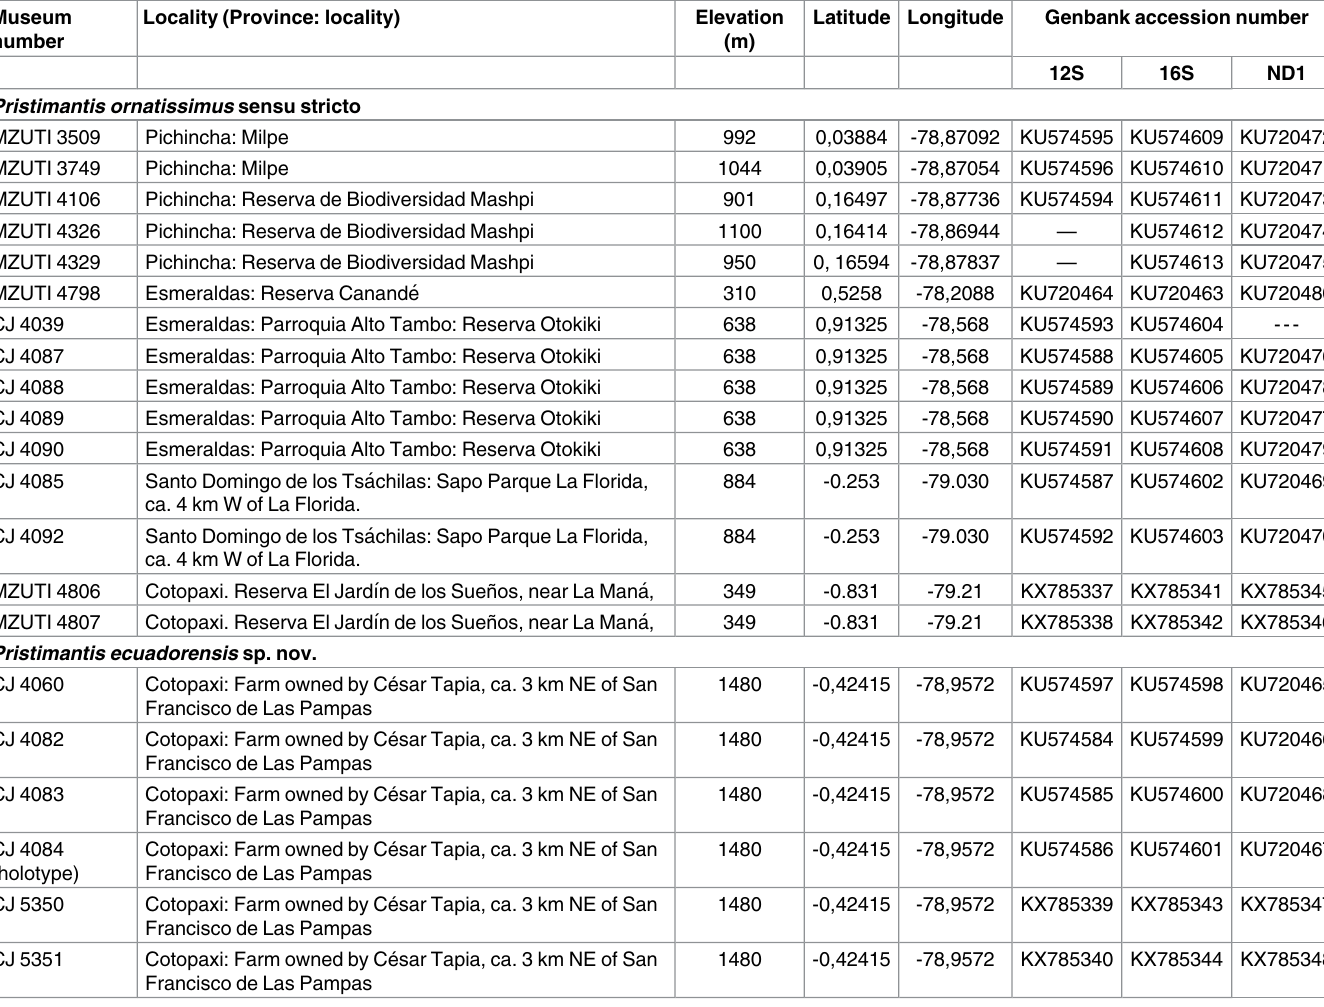
Table 1. Gene sampling of Pristimantis ornatissimus and P . ecuadorensis , with their corresponding Genbank